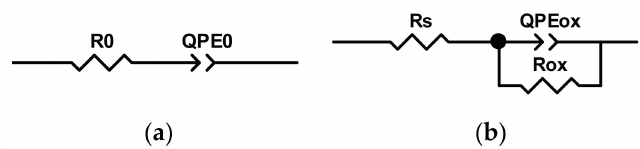
Figure 10. Equivalent circuit used to model EIS data of the AS sample: ( a ) at the beginning of the test (0 h) and ( b ) for a prolonged time of